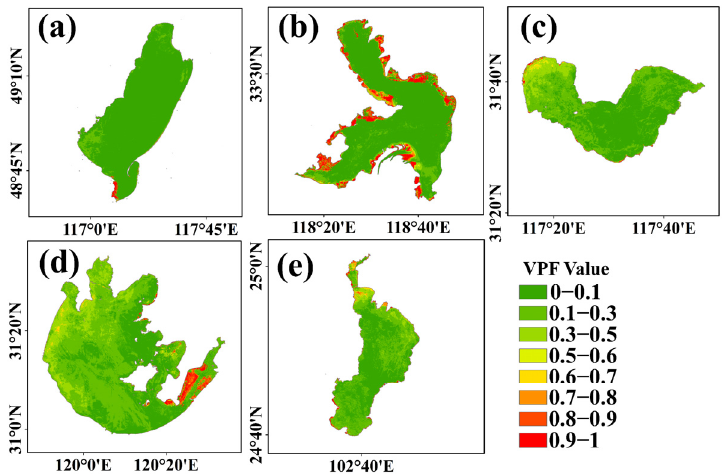
Figure 4. VPF values during periods with large areas of stable aquatic vegetation for ( a ) Lake Hulun, ( b ) Lake Hongze, ( c ) Lake Chaohu, ( d ) Lake Taihu, and ( e ) Lake Dianchi in Sentinel 2 images. The redder the area in the figure, the more frequently the vegetation signal has been present, the more probable the area is to be aquatic vegetation.